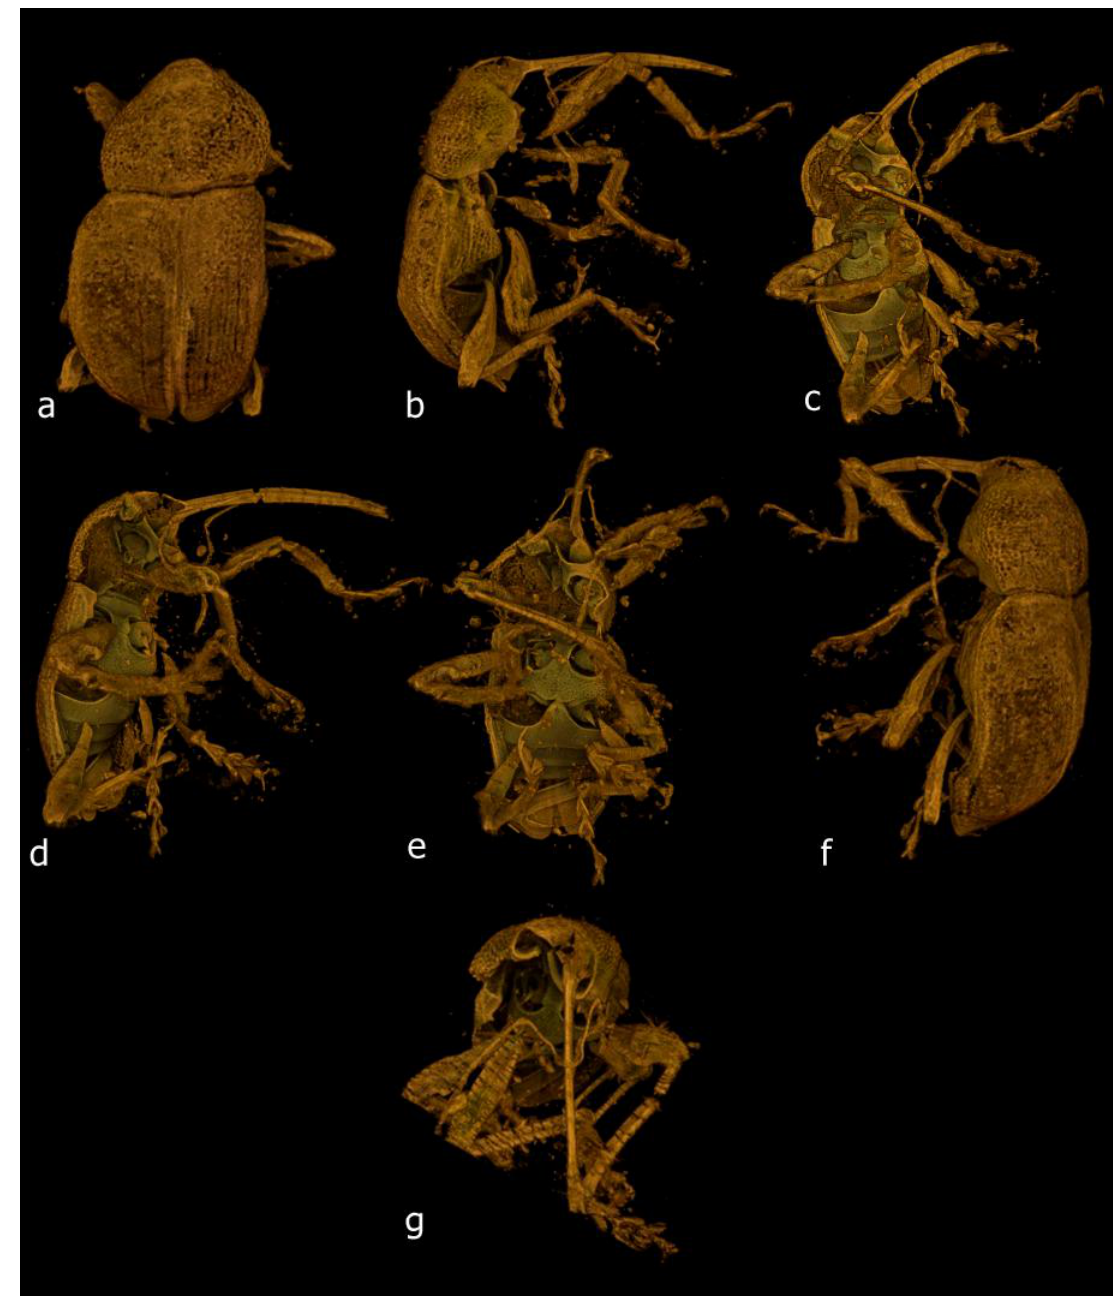
Figure 31. Cetionyx batiatus sp. n., holotype. Micro-CT scan images showing different views of the whole body, particularly useful for revealing obscured ventral details and the general effects of deformation and distortion on the shape and visibility of structures ( a–g ). See also Video S2.